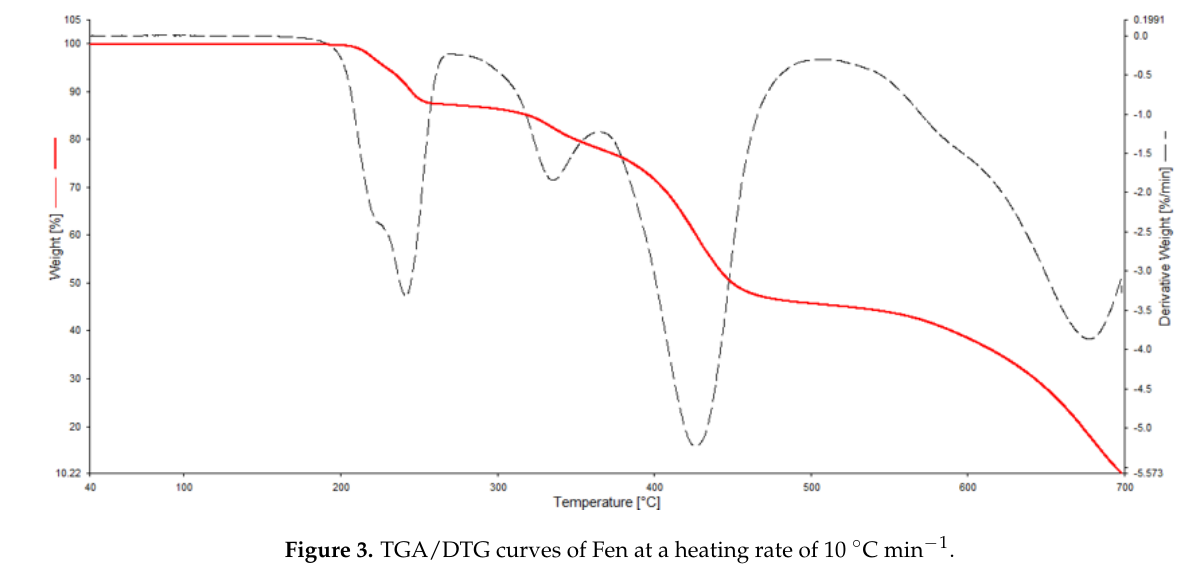
Figure 3. TGA/DTG curves of Fen at a heating rate of 10 °C min − 1 .